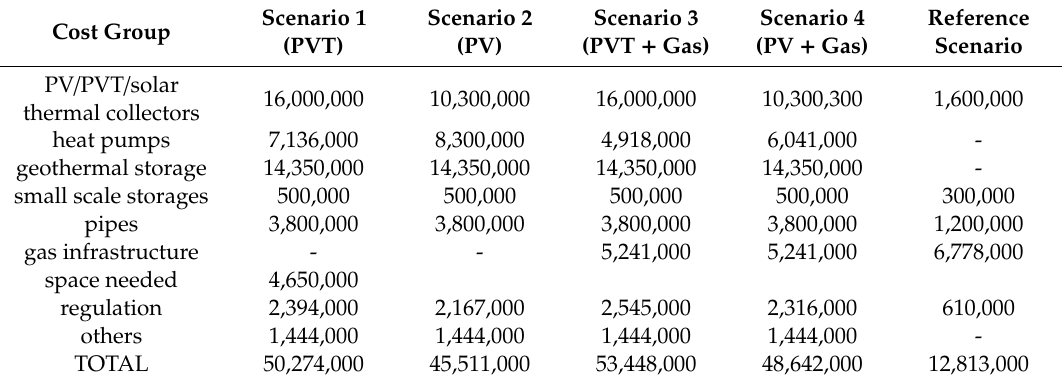
Table 10. Investment cost groups for the five supply scenarios.